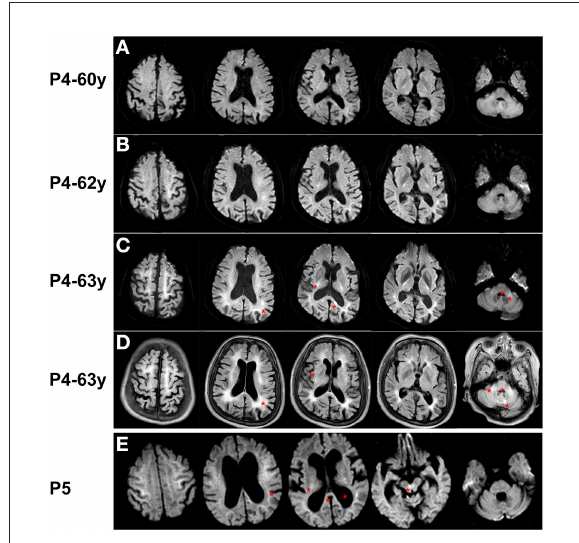
FIGURE3 Brain MRI of Patient 4 and Patient 5. (A–C) DWI sequence of Patient 4 at age 60, 62, and 63 years showed irreversible hyperintensity in the corticomedullary junction in frontal, parietal, temporal, and occipital lobes, peri-globus pallidus, left splenium of the corpus callosum, deep lobar white matter of the corona radiata, pons, and branchium pontis. (D) FLAIR sequence of Patient 4 at age 63 years revealed hyperintensity corresponding with Fazekas grade 3 staging in subcortical regions, corpus callosum, external capsule, pons, branchium pontis, and paravermal areas of cerebellum. (E) DWI sequence of Patient 5 showed ribbon sign in frontal, parietal, temporal, and occipital lobes, and high-intensity signals in thalamus, splenium of the corpus callosum, and the, and dilated ventricles (asterisks).